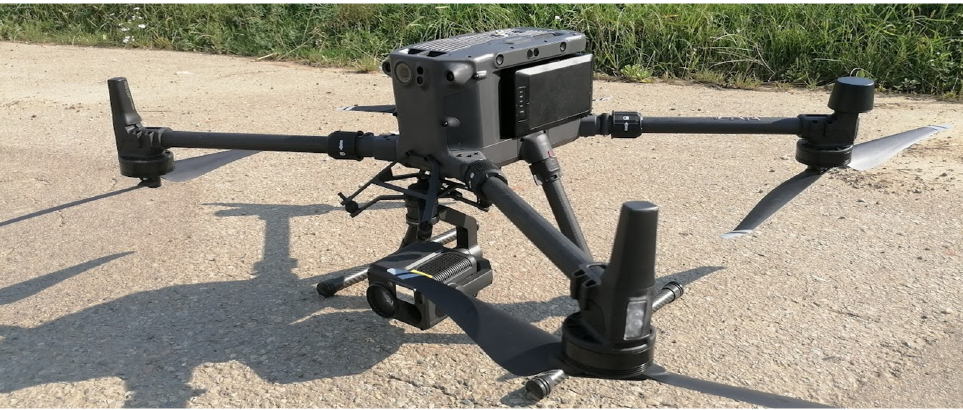
Figure 2. Measuring equipment: DJI Matrcie 300 RTK with DJI Zenmuse L1 laser scanner.